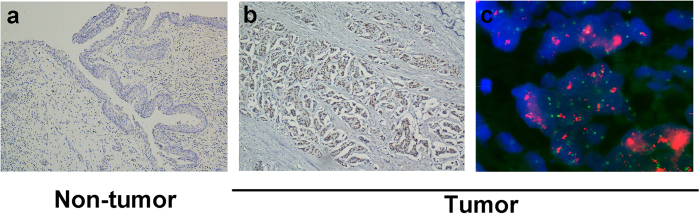
Immunohistochemical staining of RNF2 and fluorescence in situ hybridization (FISH) of RNF2 in human bladder tissues.(a) A normal bladder mucosa showed normal expression of RNF2 protein with a negative staining of RNF2 in nuclei of all normal bladder epithelial cells. Original magnification ×100. (b) A UCB (case 115) showing overexpression of RNF2, in which more than 90% of tumor cells had positive staining of RNF2 in nuclei. Original magnification ×100. (c) Amplification of the RNF2gene was observed by FISH in the same UCB case (case 115), in which RNF2 genes signals (red) were detected at least 3 times more than signals on chromosome 1 centromere (green). Original magnification ×1000.